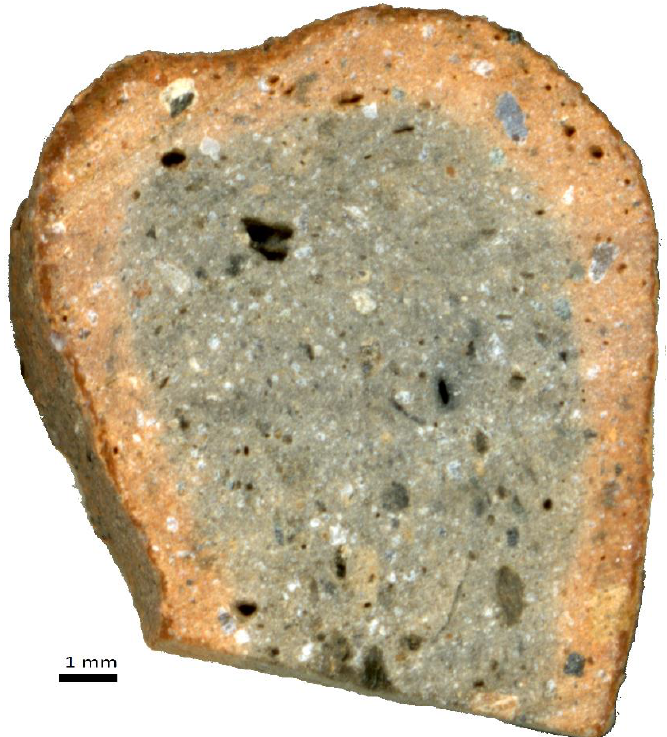
Figure 4. Ceramic cross-section showing the dark core and oxidized surfaces that are typical of ceramics from the Basin of Mexico. Note the sharp margins between oxidized/reduced zones of the fabric. Also note the thin veneer of a darker reddish hue at the surfaces that made contact with soils for the past 3000 years. This dark hue correlates with chemical anomalies due to post-depositional diagenesis.